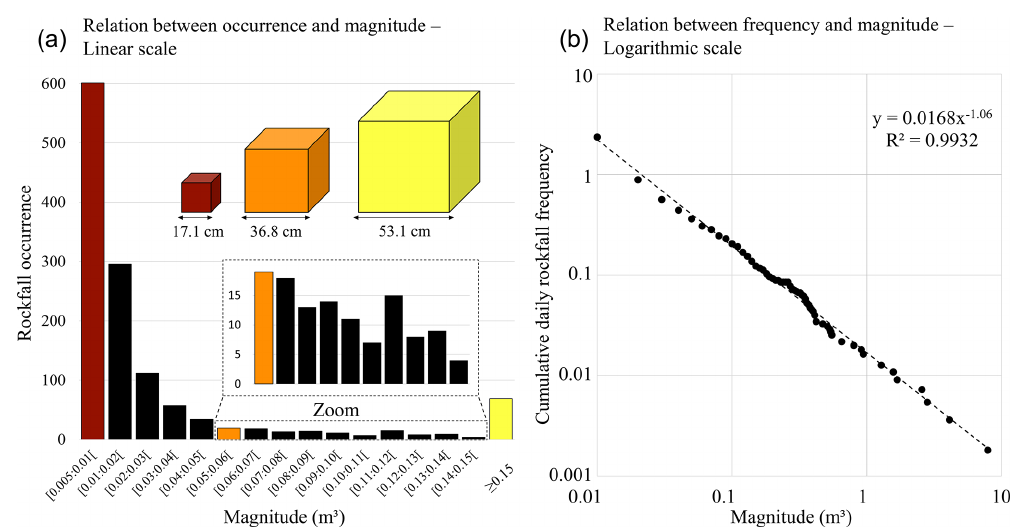
Figure 3. Relationship between rockfall occurrence and magnitude (a) and between cumulative daily rockfall frequency and magnitude (b)